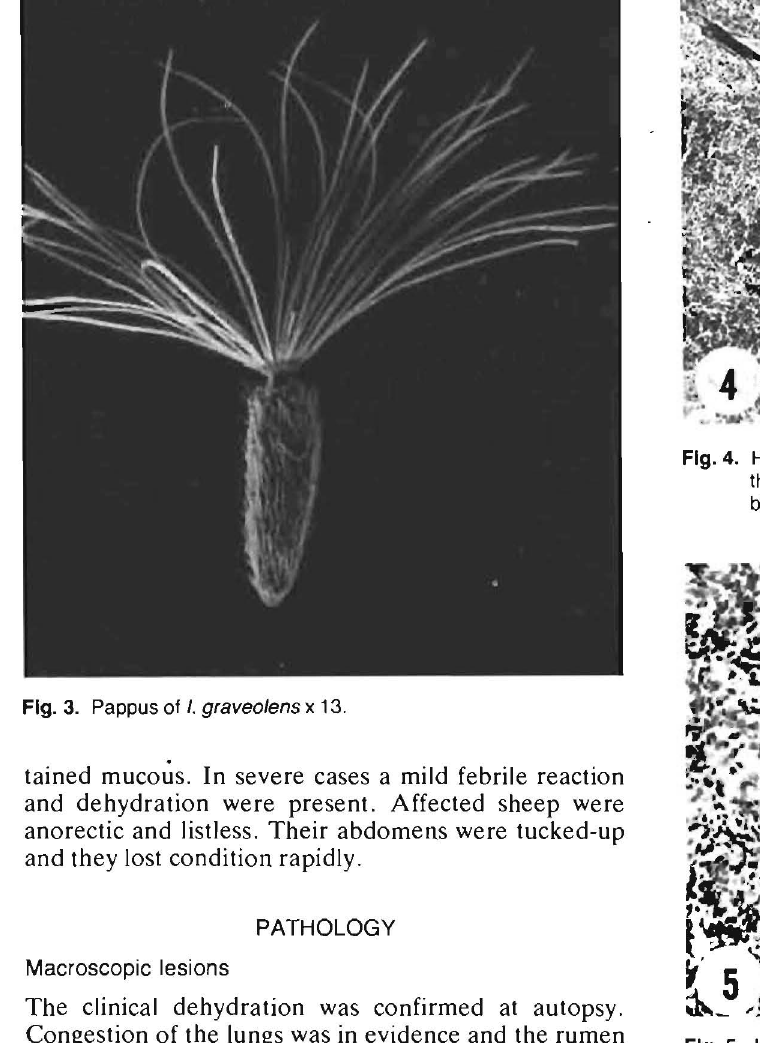
Fig. 3. Pappus of /. graveo/ens x 13.